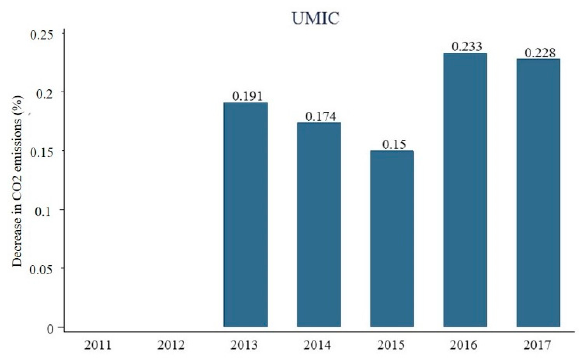
Figure 2. Effects of the policy about pollution by year at the EU level and according to the income level of the countries. Source: own elaboration based on data from WB [63] and EUROSTAT [64].